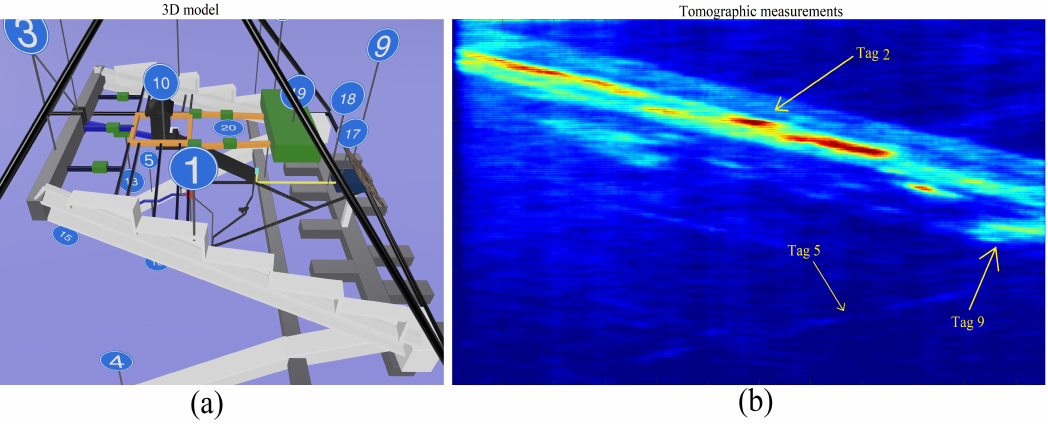
Figure 40. Tags association from tomography to 3D model. ( a ): Three-dimensional (3D) model of Khnum-Khufu (Top-East-side orientation). ( b ): Tomographic reconstruction (magnitude).